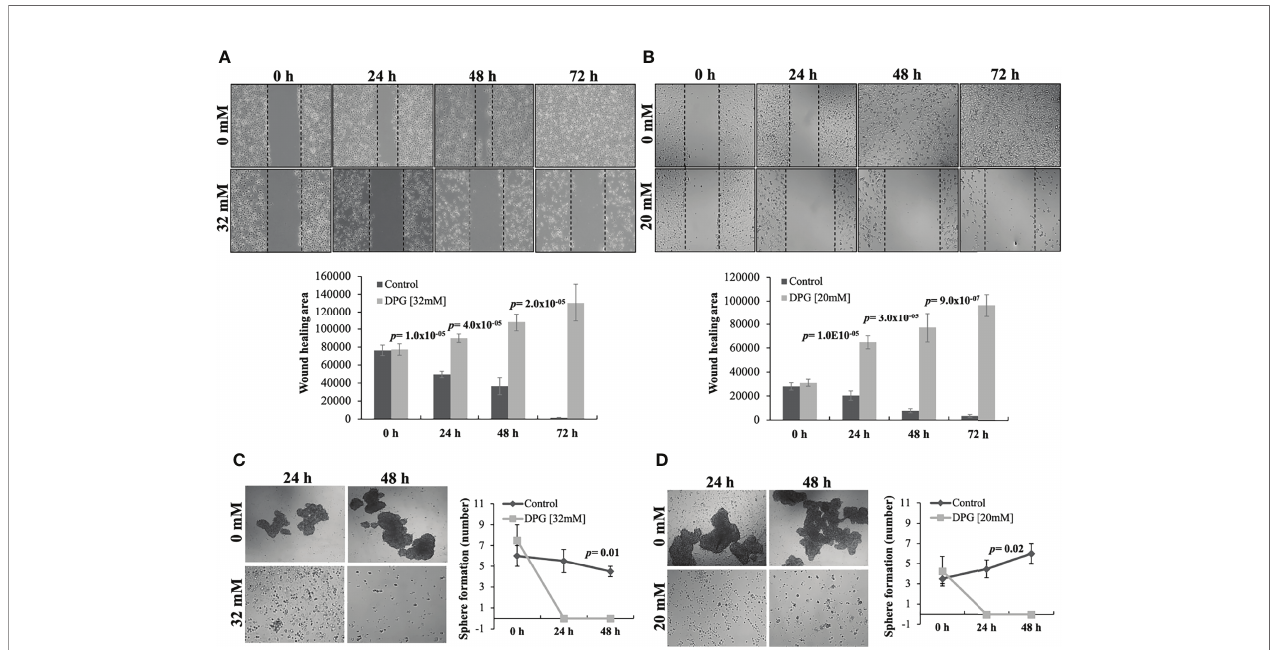
FIGURE 3 | Dipotassium glycyrrhizinate (DPG) inhibits cell migration and cancer stem-like cells in glioblastoma cell lines. (A) U251 and (B) U138MG cell lines treated with DPG fi ll the wound area (the area between the two dotted lines) more slowly at 24, 48, and 72 h when compared to untreated control cells ( p -value ≤ 0.001). The wound-healing assay was quanti fi ed using the ImageJ computer program by measuring the relative area of the wound after treatment with DPG. Loss of sphere- forming capacity of cell lines (C) U251 ( p -value = 0.01) and (D) U138MG ( p -value = 0.02) after 24 and 48 h of treatment with DPG when compared to untreated control cells. The data presented are the mean ± standard deviation of the experiments performed in triplicate.